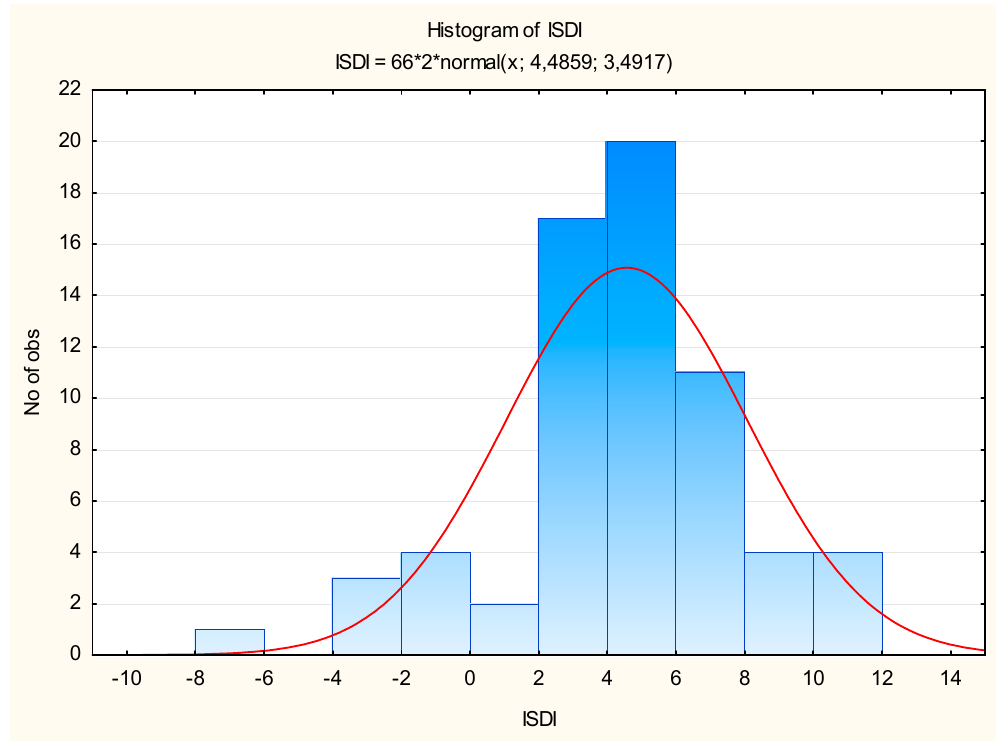
Figure 1. Frequency distribution diagram for the ISDI variable.